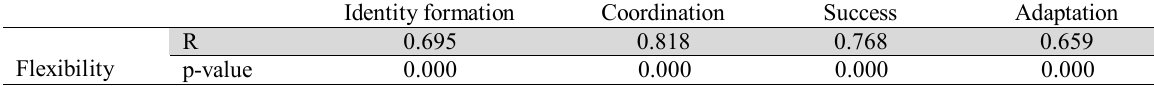
The results of correlation between flexibility and human resource development Identity formation Coordination Success Adaptation Flexibility